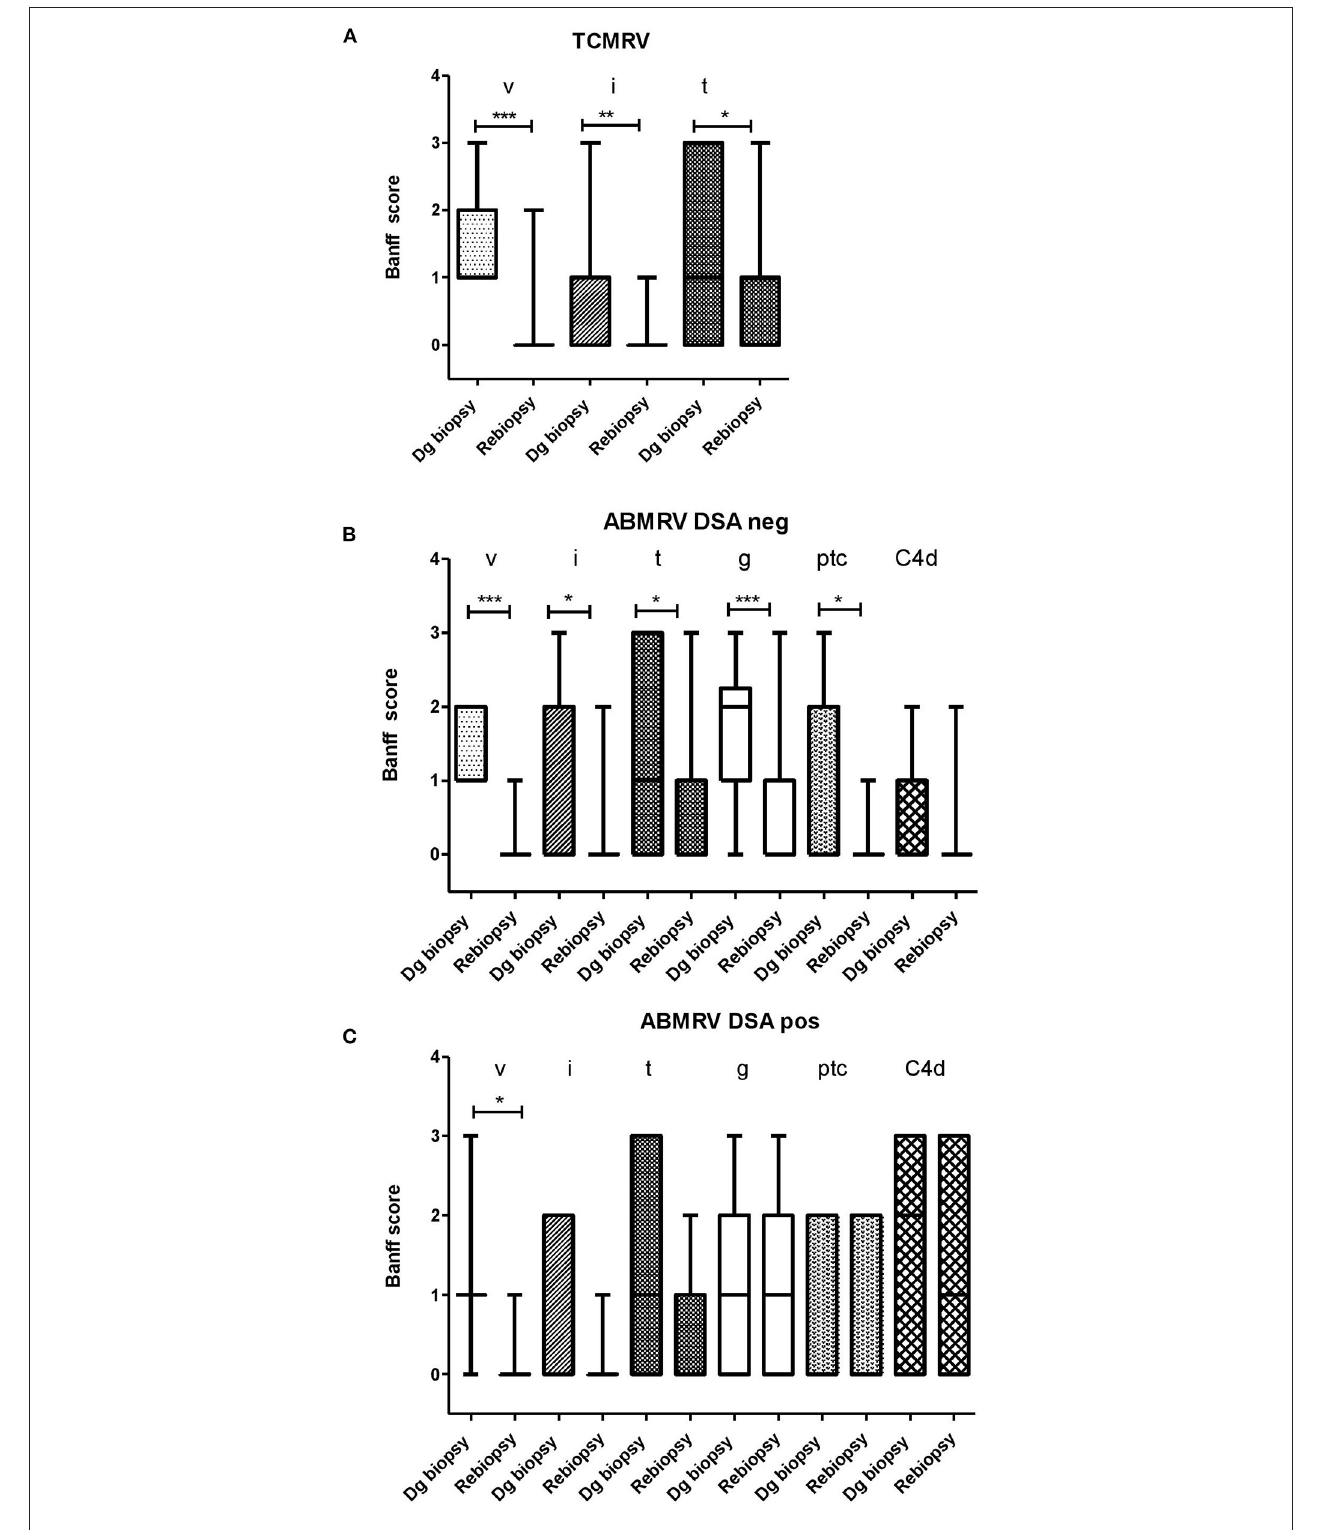
FIGURE 2 | The development of Banff score between diagnostic (dg biopsy) and rebiopsies in a subgroup of patients with consented rebiopsies. (A) TCMRV ( n = 21) (B) ABMRV DSA– ( n = 22) and (C) ABMRV DSA + ( n = 15). Differences were calculated by Wilcoxon matched-paired signed rank test. * p < 0.05, ** p < 0.01, and *** p <